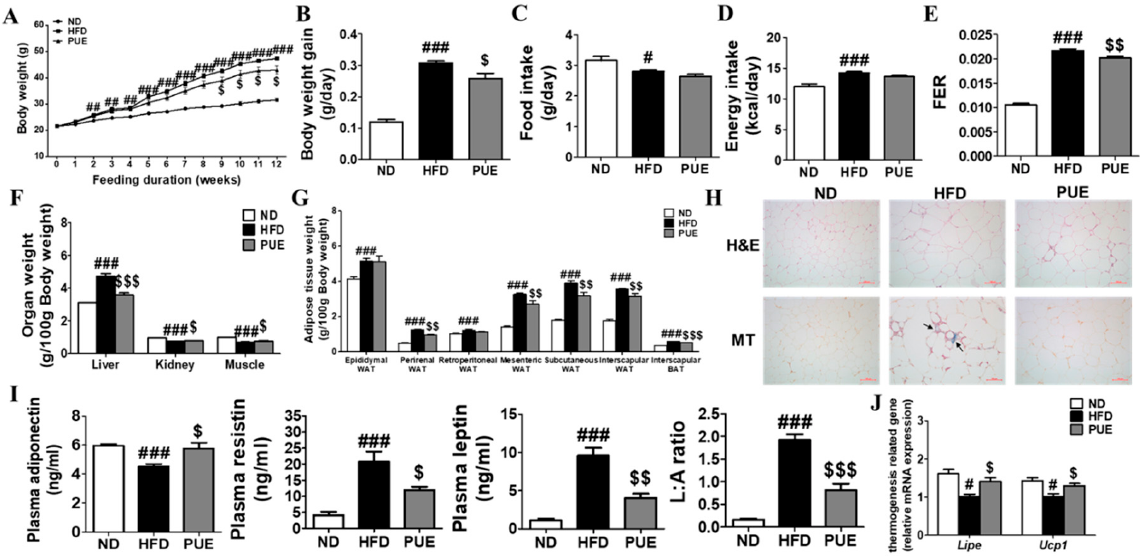
Figure 2. Effect of P. umbrosa root extract supplement on body and fat weights, adipose tissue morphology, adipokines, and mRNA expression in DIO mice. ( A ) Body weight; ( B ) Body weight gain; ( C ) Food intake; ( D ) Energy intake; ( E ) FER; ( F ) Organ weight; ( G ) Adipose tissue